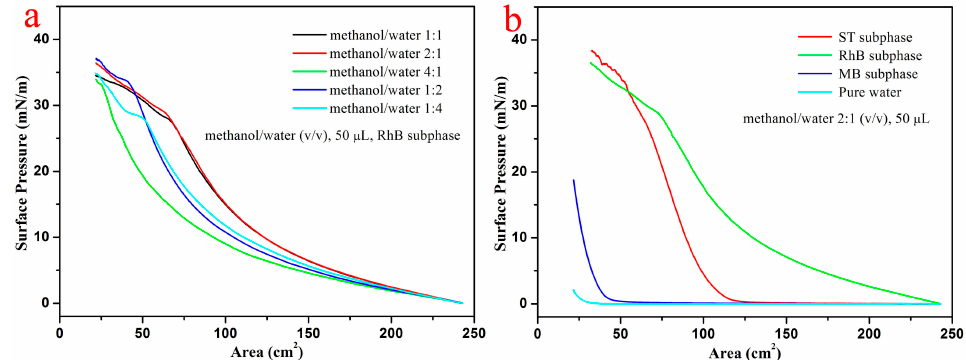
Figure 2. Surface pressure-area isotherms of as-prepared MXene-SO3H Langmuir film spreading on: ( a ) RhB sub phase, different mixed solvent ratios; ( b ) different dye sub phases (methanol/water ( v / v ) of 2:1, volume of 50 µ L and concentration of 0.7 mg mL − 1 ).